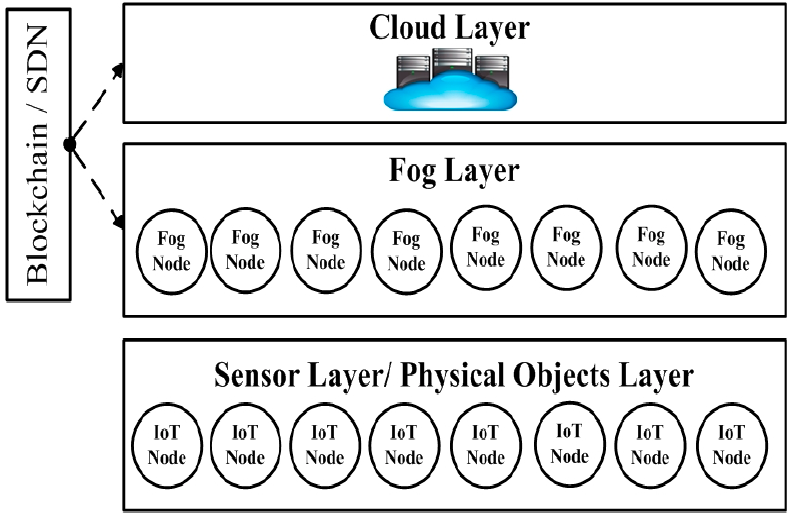
Figure 1. The main layers of the proposed Internet of Things (IoT)-Fog system.